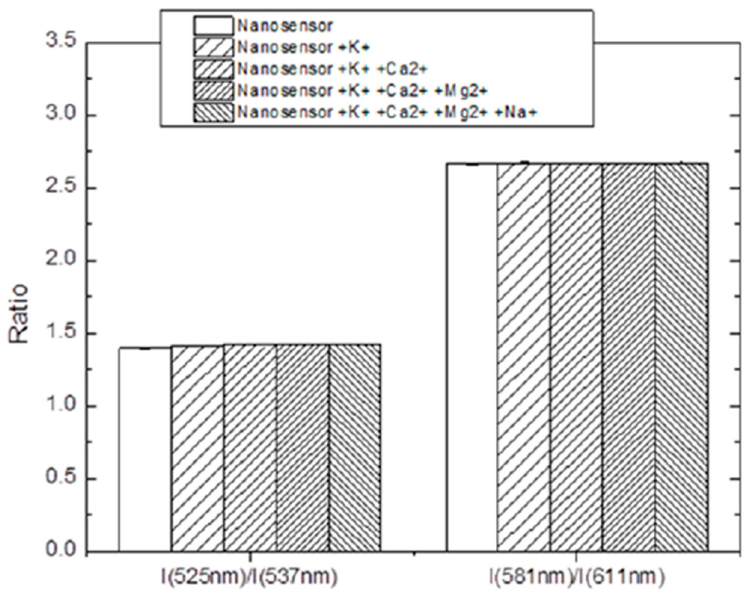
Figure 3. Stability of the ratios for nanosensors toward metal ions (1 mM) K + , Ca 2+ , Mg 2+ and Na + .